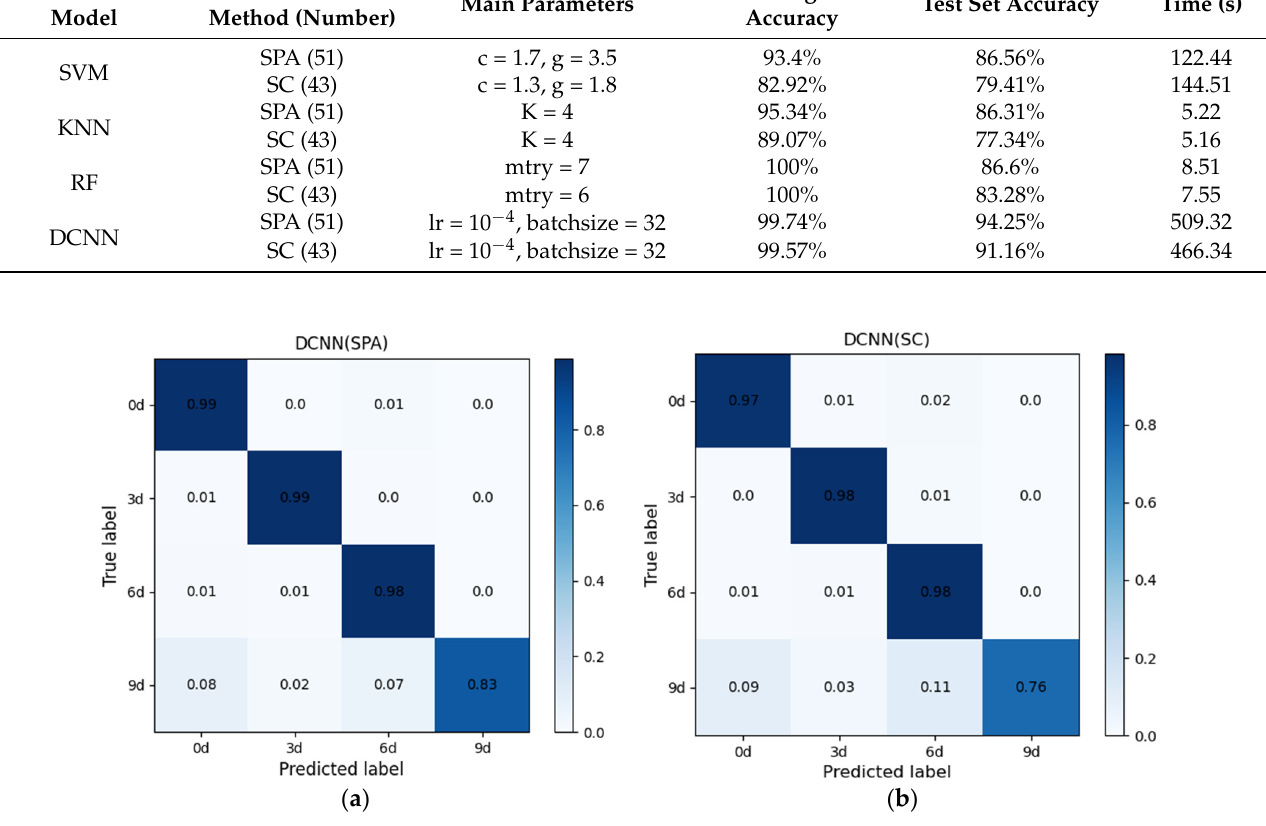
Figure 9. Confusion matrix based on characteristic wavelength. ( a ) Confusion matrix based on SPA; ( b ) confusion matrix based on SC algorithm.